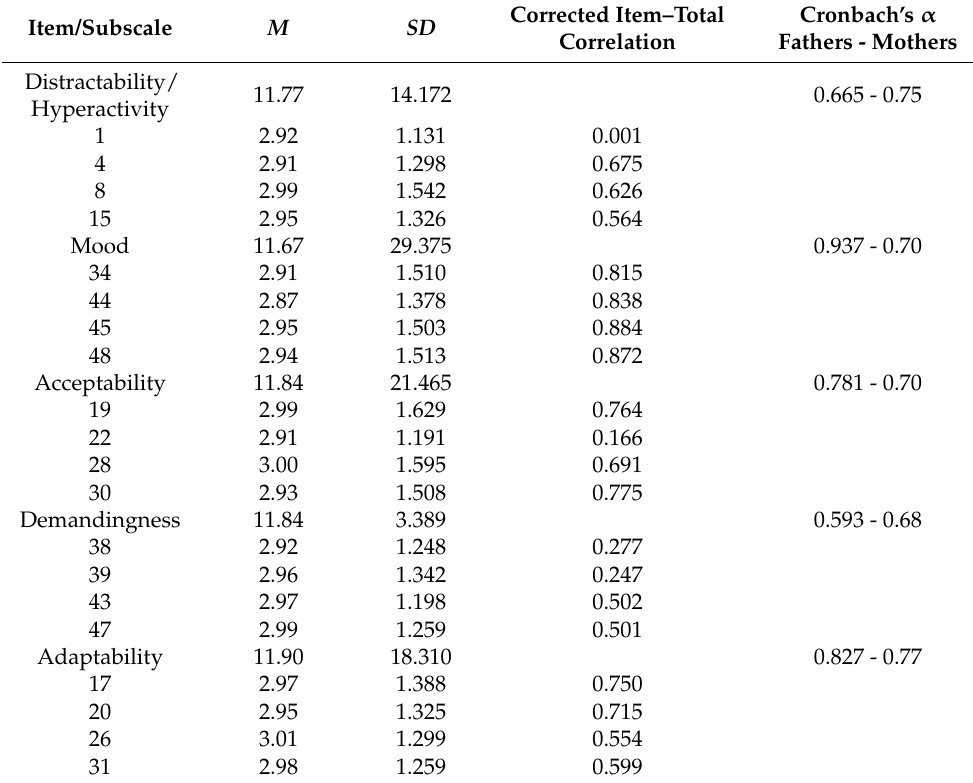
Table 2. Item analysis of the EBI regarding Child Characteristics for Fathers.